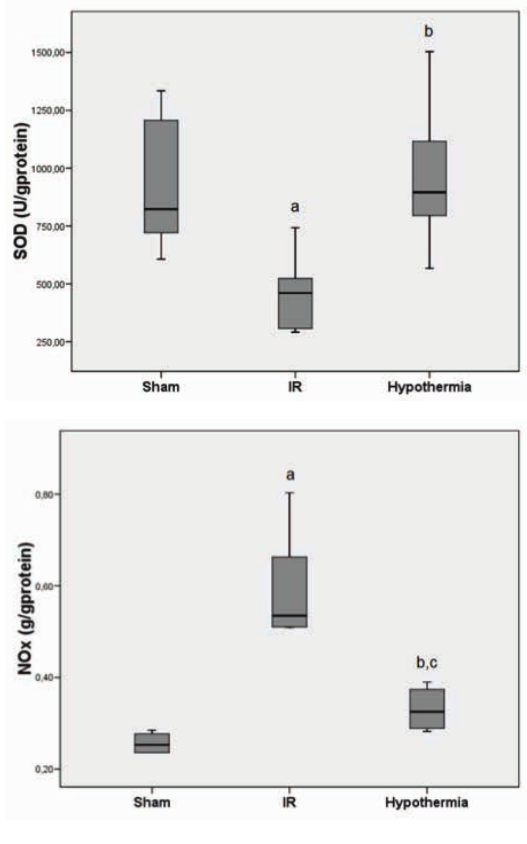
Figure 1. Muscle level of MDA, NOx, IL-1B, SOD,and GSH-Px in all groups (median±standart deviation). aP< 0.05 compared between sham and I/R groups, bP< 0.05 compared between I/R and hypothermia groups, cP< 0.05 compared between sham and hypothermia